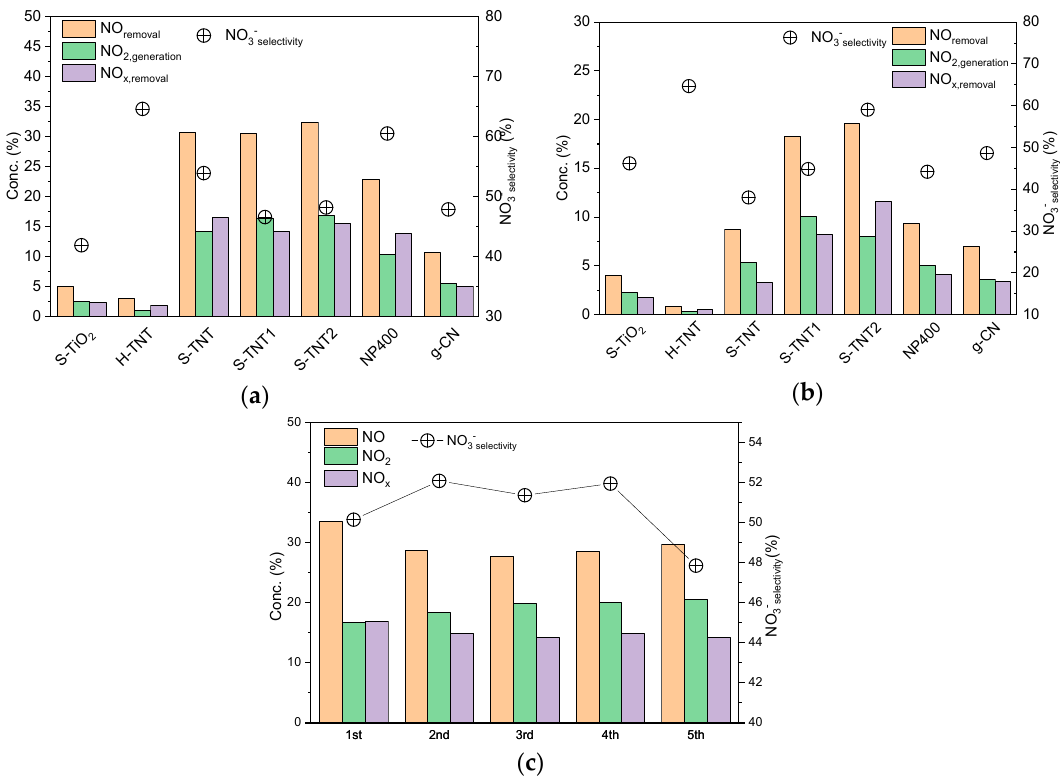
Figure 6. Eestimated NO removal , NO 2,generation , NO x,removal , and NO 3 − selectivity profile of the as-synthesized samples along with NP400, under UV ( a ) and visible light ( b ); ( c ) recycling experiments for NO removal under UV irradiation over S-TNT2.